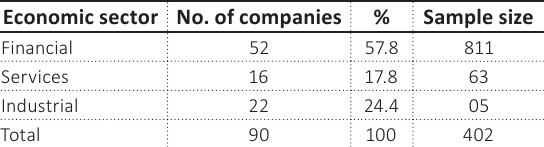
Table 4. Distribution of the sample by economic sectors